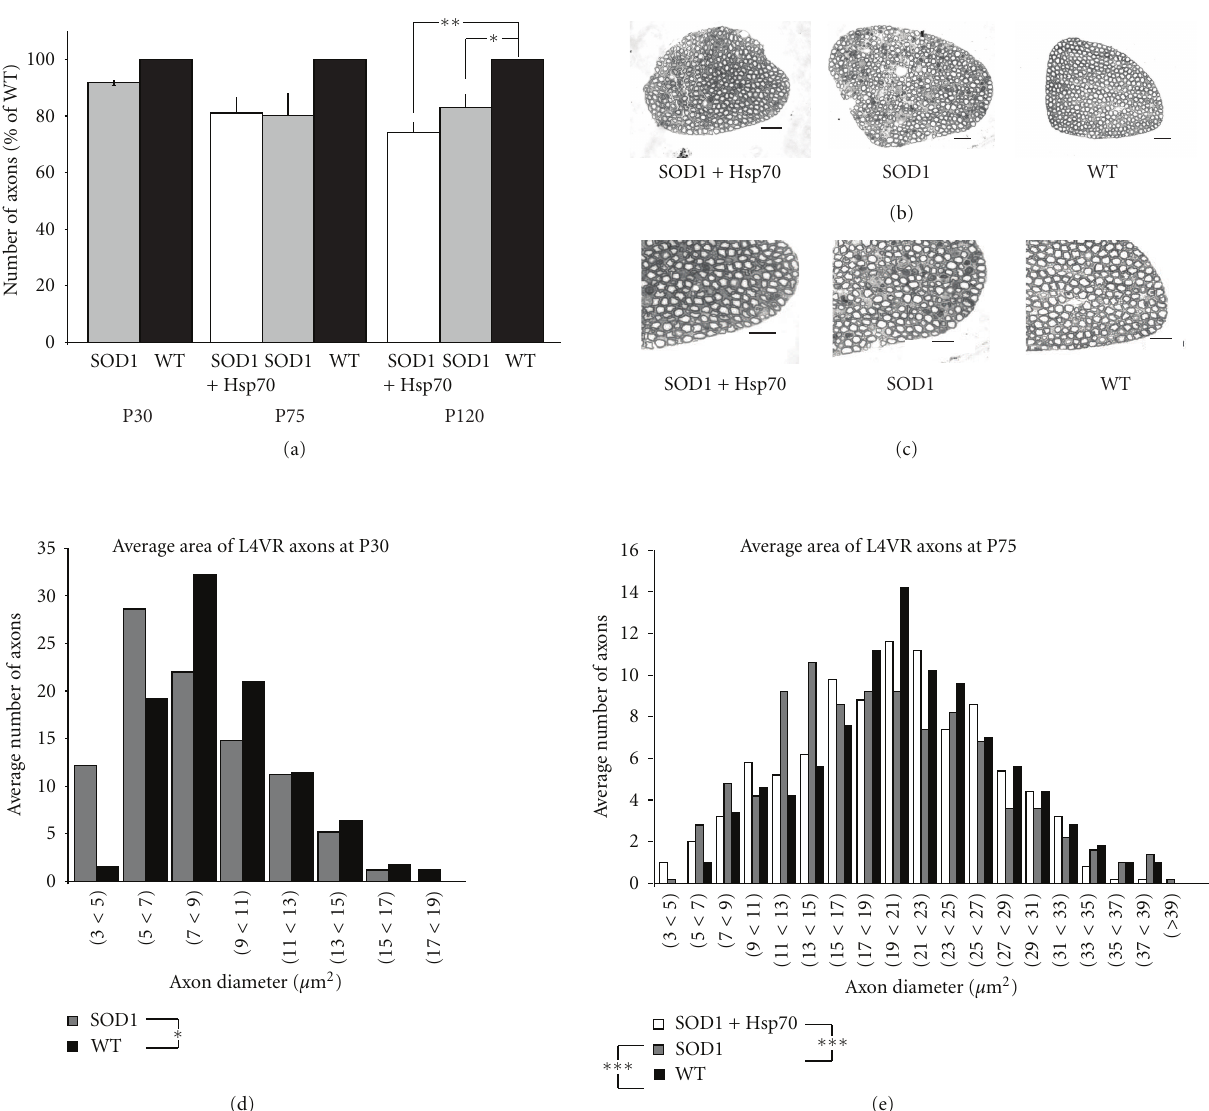
Figure 2: rhHsp70 injections preserve larger axons in the L4VR. (a) There was no di ff erence in the overall number of myelinated axons in the 4th lumbar ventral root at P30 or P75 although there appears to be a trend toward decreased numbers in the SOD1 groups at P75. Data are represented as percent of WT ± SEM at each time point. N = 5 for each group. Statistical significance was determined by running an ANOVA, followed by the Tukey-Kramer multiple comparisons post-hoc test. (b) Although there was not a significant di ff erence in the number of axons in treated and untreated mice, photomicrographs suggest that disease morphology of myelinated axons has progressed more in untreated mice as compared to treated animals. Photomicrographs of myelinated axons were taken at 40x. Scale bars = 40 μ m. (c) Enlargements of photomicrographs of myelinated axons taken at 40x. Scale bars = 40 μ m. (d) Size profiles of the axon area revealed a greater number of larger axons in WT animals ( ∗ P < 0 . 05). Data are representative histograms of the average area of myelinated axons in the L4VR of SOD1-untreated and WT mice at P30. Statistical significance was determined by running a two-way ANOVA. Axons were traced using a camera lucida at 40x scanned and average axon area was determined using Scion Image software. Data are represented as the average number of axons per area range. N = 5 for each group. (e) There were a greater number of larger axons in SOD1-treated and WT animals as compared to SOD1-untreated mice ( ∗∗∗ P < 0 . 001) at P75. There was no significant di ff erence in the number of larger axons between SOD1-treated and WT animals. Data are representative histograms of the average number of axons per area range. N = 5 for each group at P75. Statistical significance was determined using repeated measures (mixed model) ANOVA. Statistical significance was determined using repeated measures (mixed model)